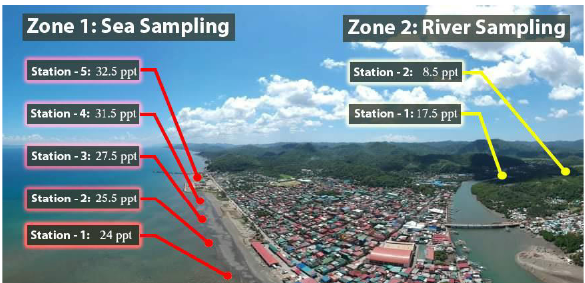
Figure 7 . Measured salinity concentration of different locations on the river and nearshore, where the reclamation shall be done.